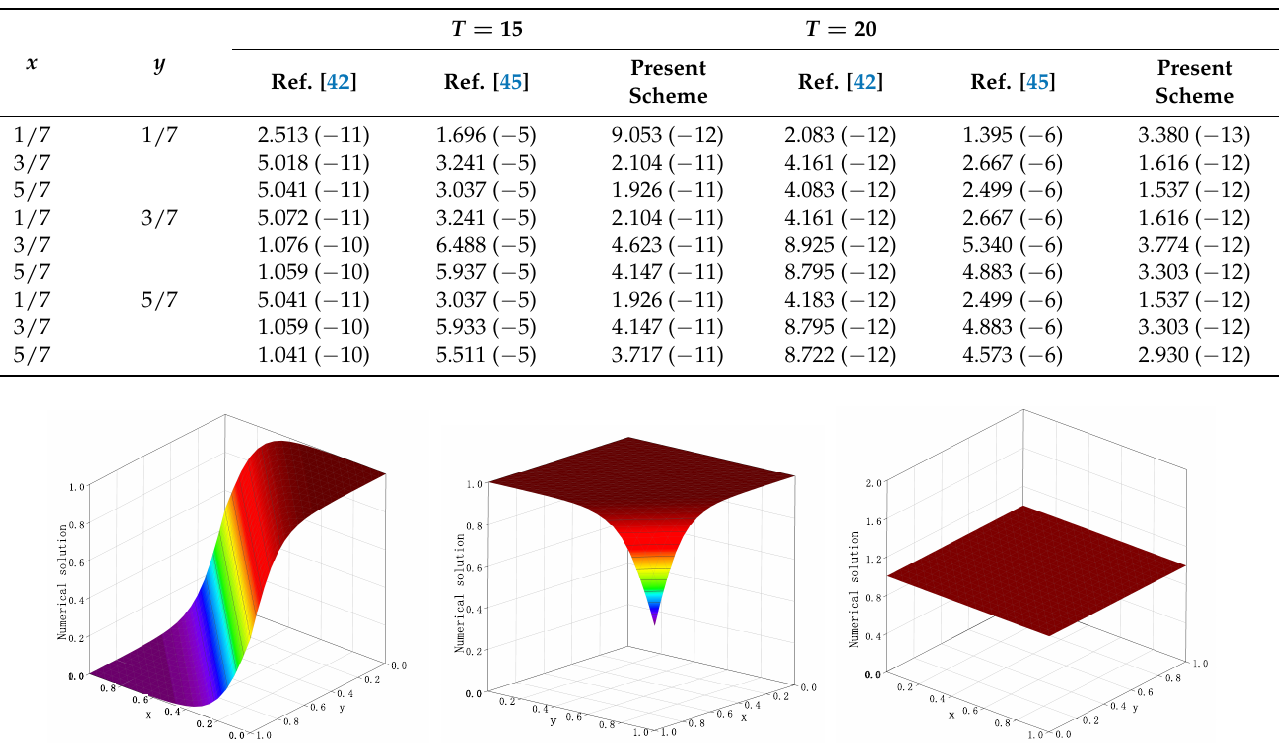
Figure 2. The numerical solution when h = 0.05, τ = 0.001 and α = 0.05 for problem 1. left: T = 1; middle: T = 2; right: T = 4.